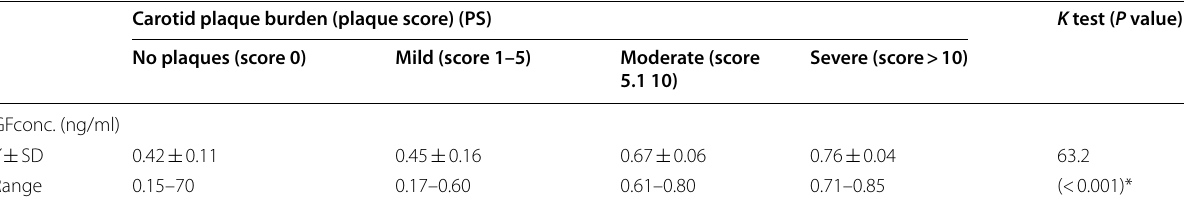
X mean, SD standard deviation, K Kruskal–Wallis test, *highly significant, HGF hepatocyte growth factor, PS plaque score